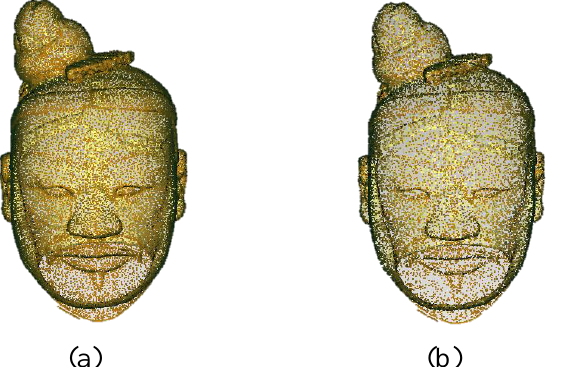
Figure 5. ( a ) Point cloud of points directly acquired by the 3D scanner; ( b ) point cloud after the downsampling procedure with a sampling coefficient of 60%.